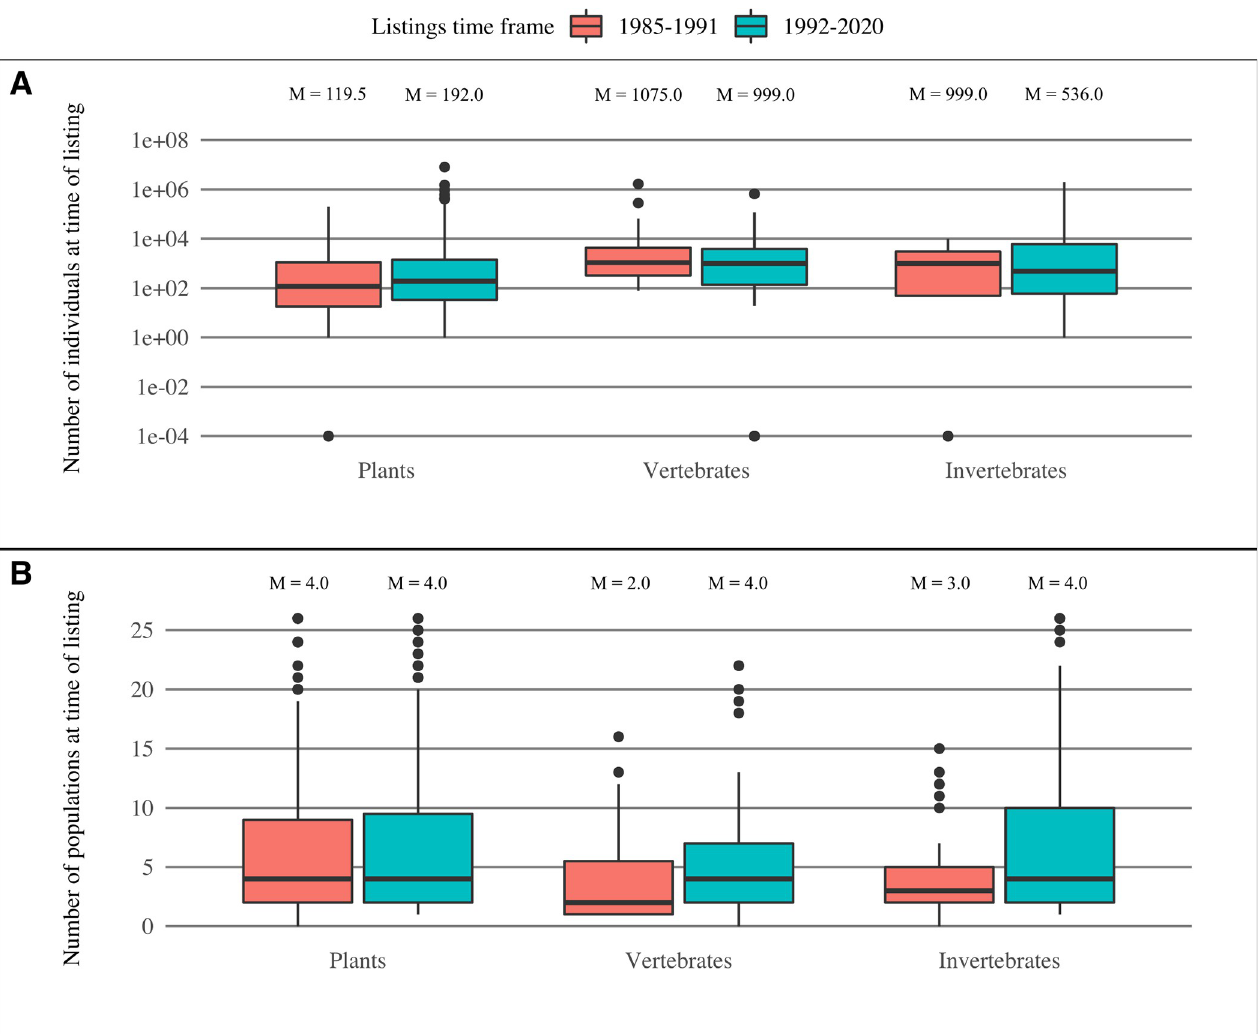
Fig 1. Species status at time of listing, 1985–1991 versus 1992–2020. (A) Comparison of population size at time of listing for plants and animals. There are no significant differences between the two periods (Wilcox Test values of p = 0.08, p = 0.41, and p = 0.66, for plants, vertebrates and invertebrates respectively). (B) Comparison of number of populations at time of listing. There are no significant differences between the two periods for plants and invertebrates. Values of zero indicate species for which there were either no known individuals or no known populations at time of listing. Median values shown above each